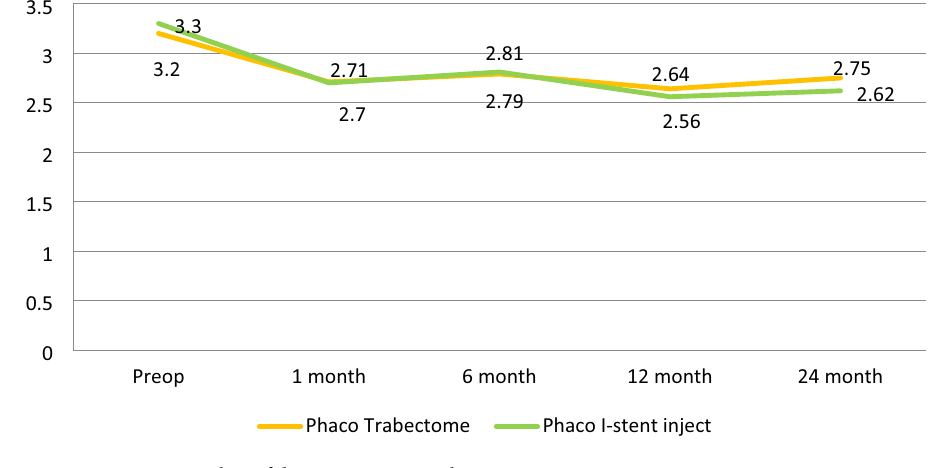
Figure 3. Mean number of drops over 24 months.